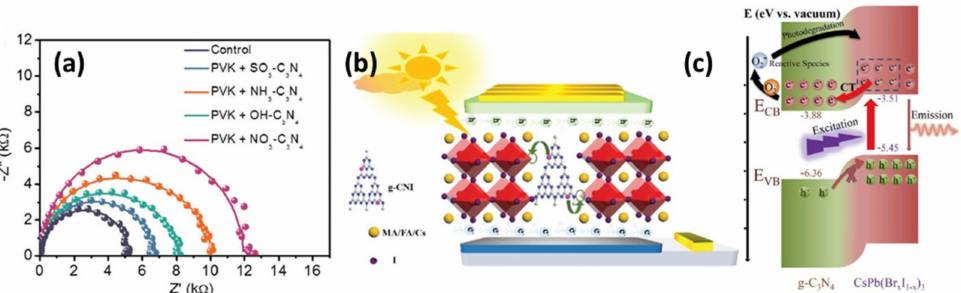
Figure 8. ( a ) Nyquist plot of control and devices passivated by functionalized C 3 N 4 . Reproduced with permission from [99], Copyright 2019, Wiley-VCH GmbH. ( b ) Schematic diagram of the mechanism of g-CNI modified PSCs. Reproduced with permission from [100], Copyright 2019, The Royal Society of Chemistry. ( c ) Schematic illustration of charge transfer